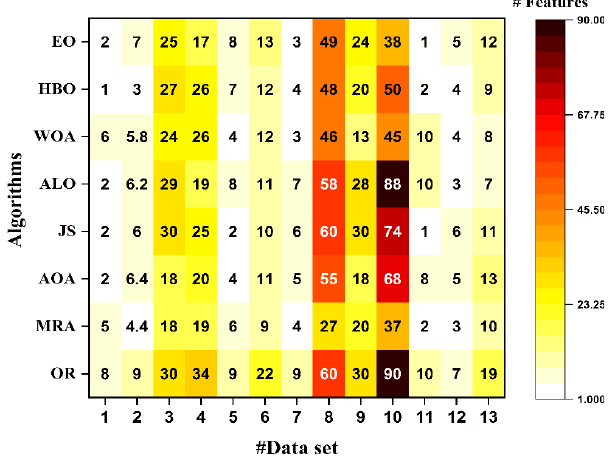
Figure 2. Comparison between the feature selection values of the proposed algorithm and other algorithms.